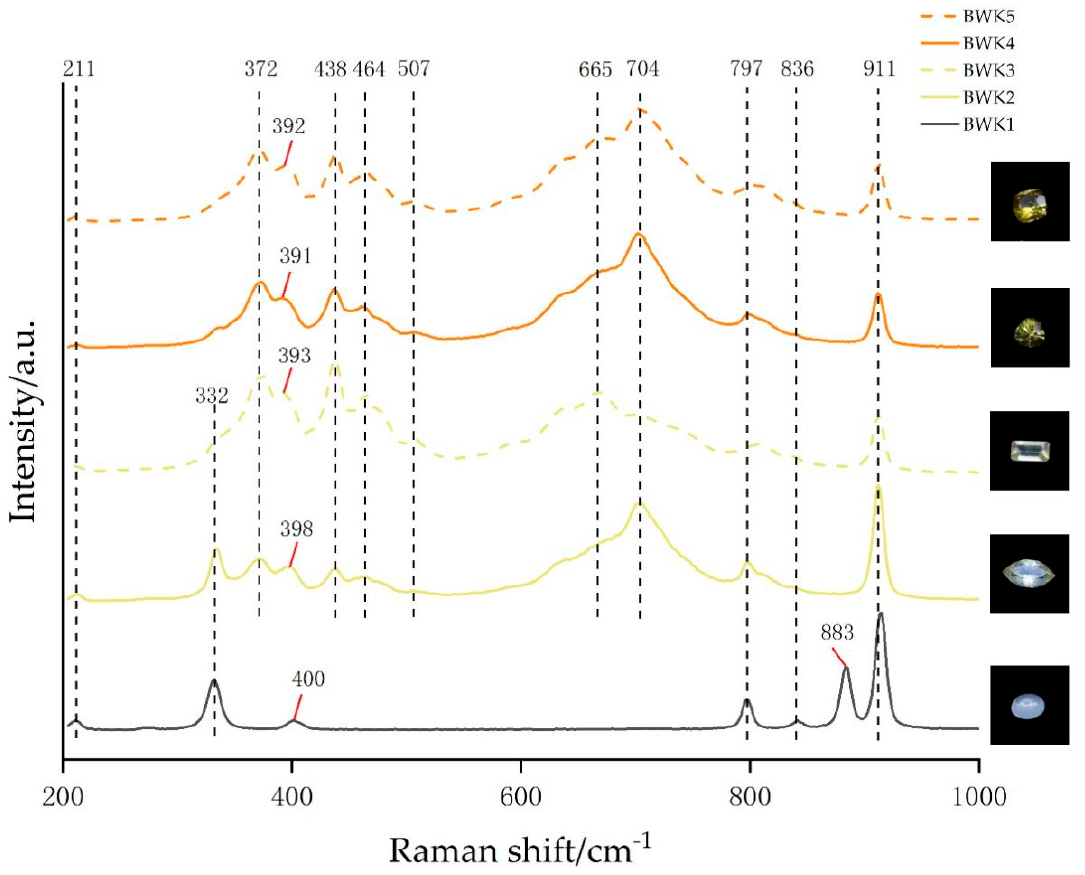
Figure 6. Raman spectra of scheelite samples BWK1 − 5. Table 2. Raman analysis of scheelite samples BWK1 − 5.